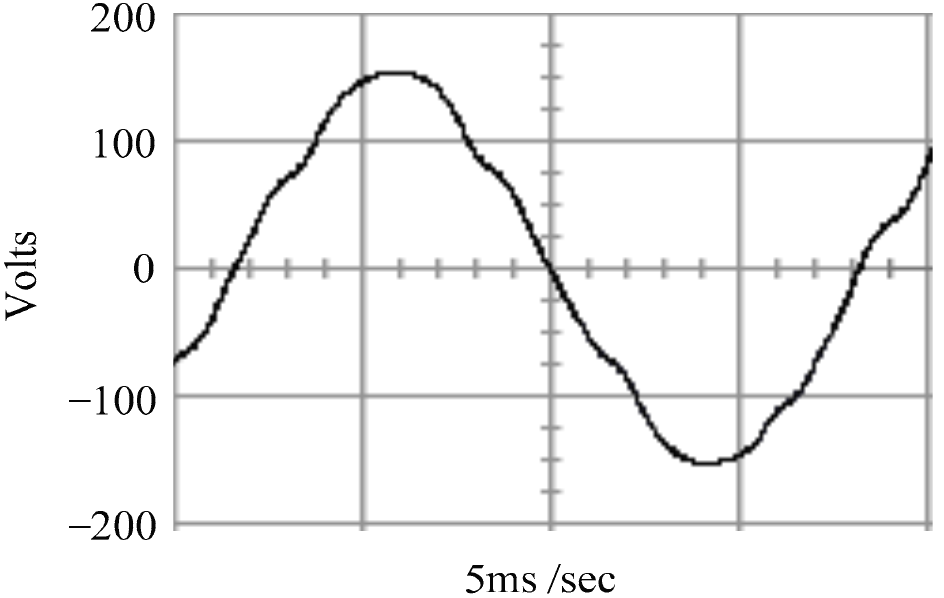
Figure 13. Experimental output voltage with the conventional SMC under LC parametric variations.